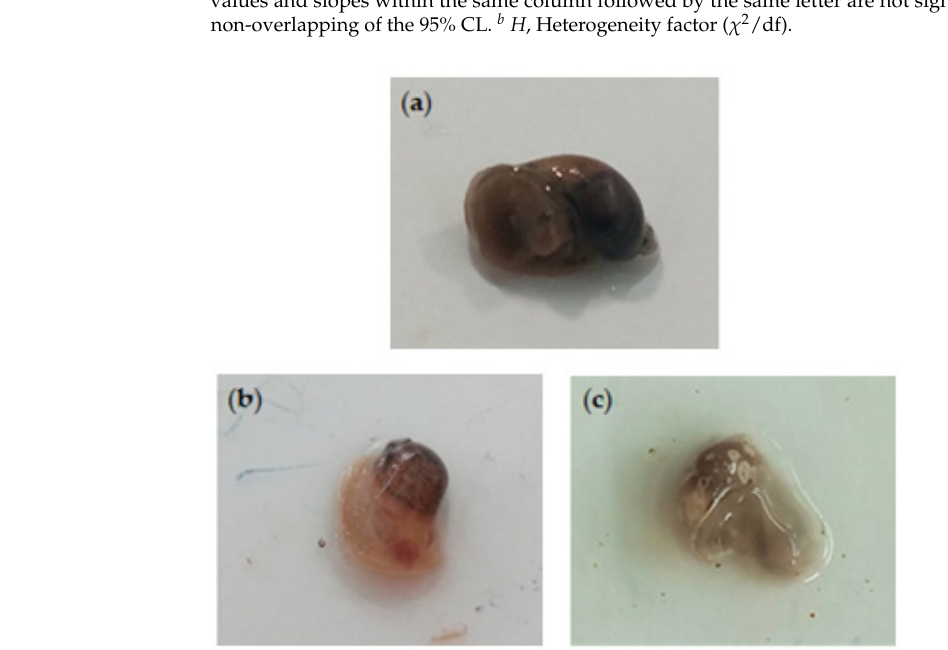
Figure 3. Radix peregra adults in immersion test. Control snails (untreated) ( a ) vs. snails treated with Azorean Cryptomeria japonica leaf essential oils exhibited swelling of cephalopedal mass ( b ) and hemolymph leakage and tissue discoloration ( c ).